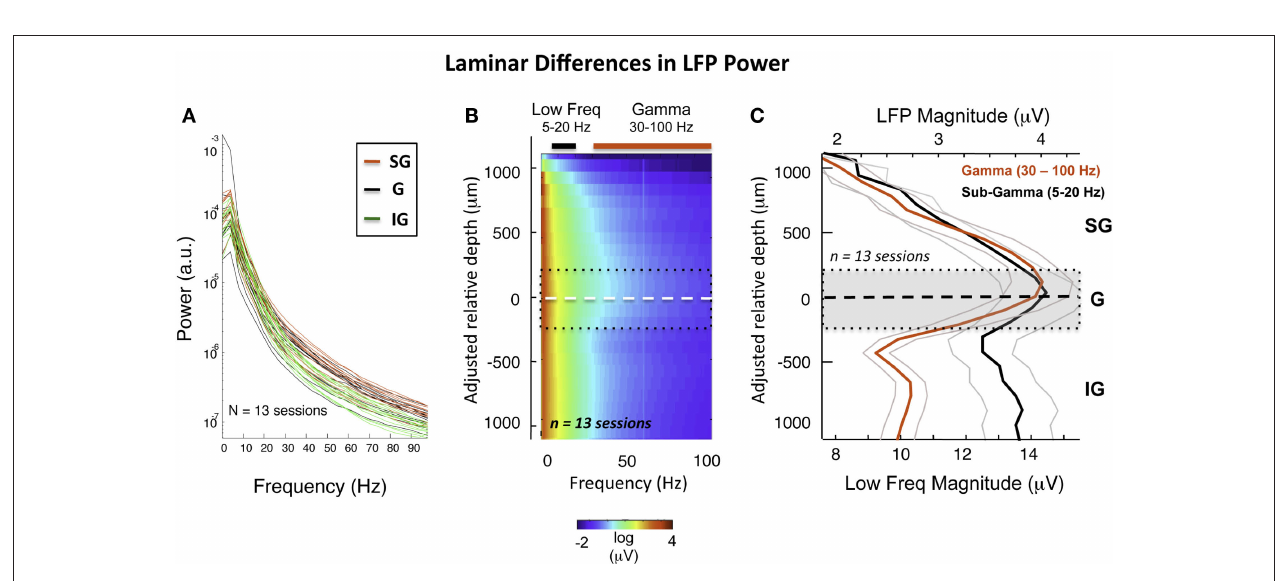
The elevated high-frequency activity in the middle and upper layers is clearly visible. The colored bars indicate the frequency range used to compute mean LFP magnitude in (C) . (C) Laminar distribution of LFP amplitude in gamma and sub-gamma-ranges during rest. Note that the mean gamma-range amplitude is highest in the middle and upper